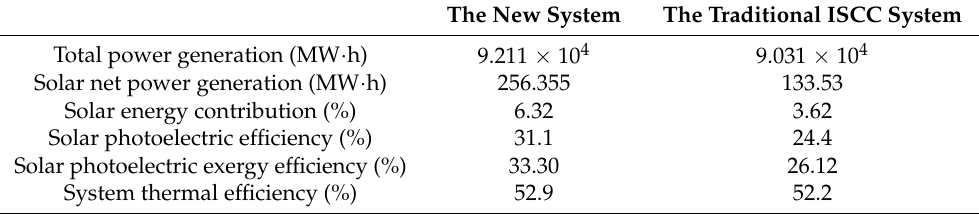
Table 7. Thermodynamic performance parameters for a typical summer day.